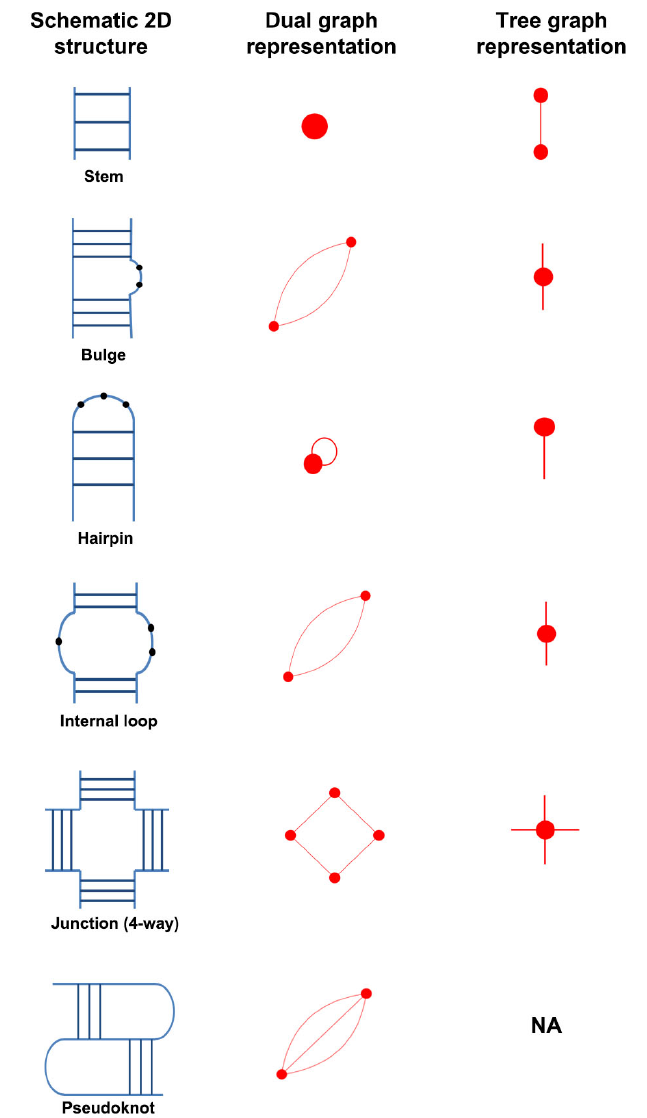
Figure 1. Dual graph representations of common RNA 2D structure building blocks. In dual graphs, stems with at least two base pairs are denoted by vertices. All loop strands (with or without residues) are represented as edges, except for single-residue bulges and internal loops with only one residue in each strand, which are ignored. The tree graph representations are also shown for comparison. Note that pseudoknots cannot be represented by tree graphs (indicated by Not Applicable (NA)) because they contain intertwined and non-nested base